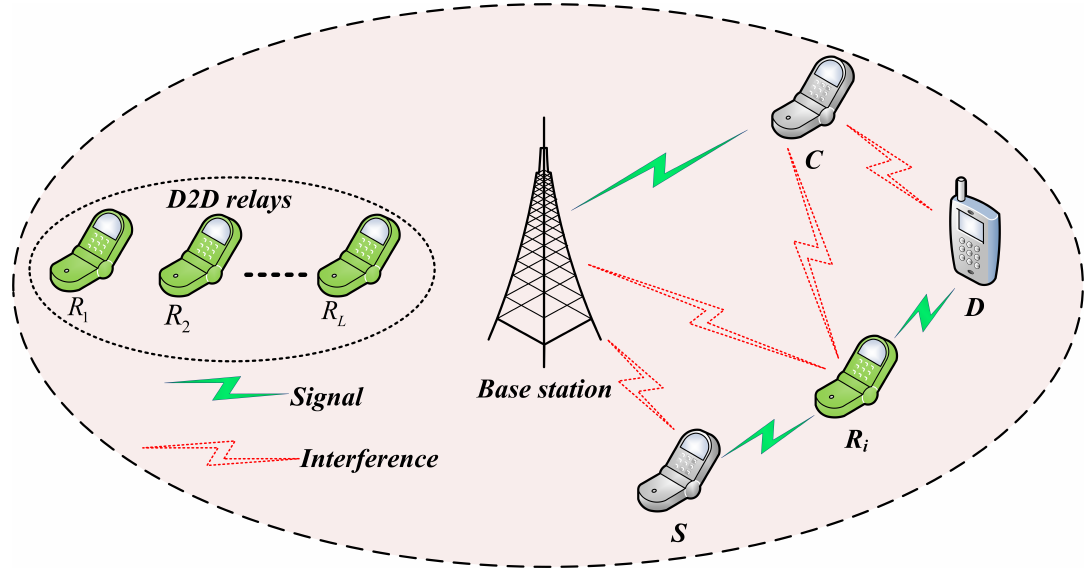
Figure 1. System